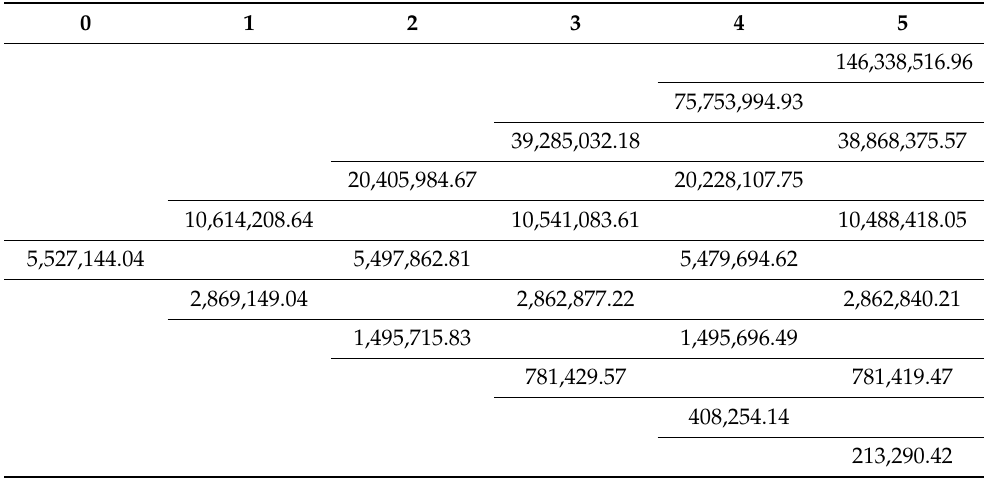
Table 6. Real Option binomial tree ( € ). 0